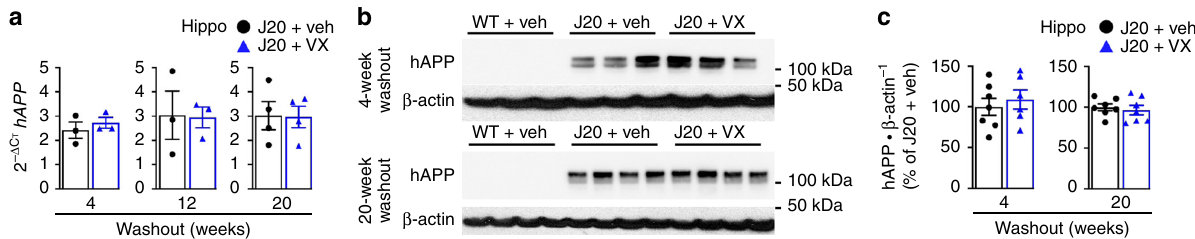
Fig. 3 Pre-symptomatic VX-765 treatment does not alter APP expression in J20 mice. a hAPP mRNA levels in the hippocampus at 4-week ( n = 6 mice per group), 12-week ( n = 3 mice per group) and 20-week ( n = 4 mice per group) WO. b hAPP western blot and c quanti fi cation in the hippocampus at 4- week ( n = 7 J20 + veh, 6 J20 + VX) and 20-week ( n = 7 mice per group) WO using the human speci fi c 6E10 antibody. Data in ( a ) and ( c )